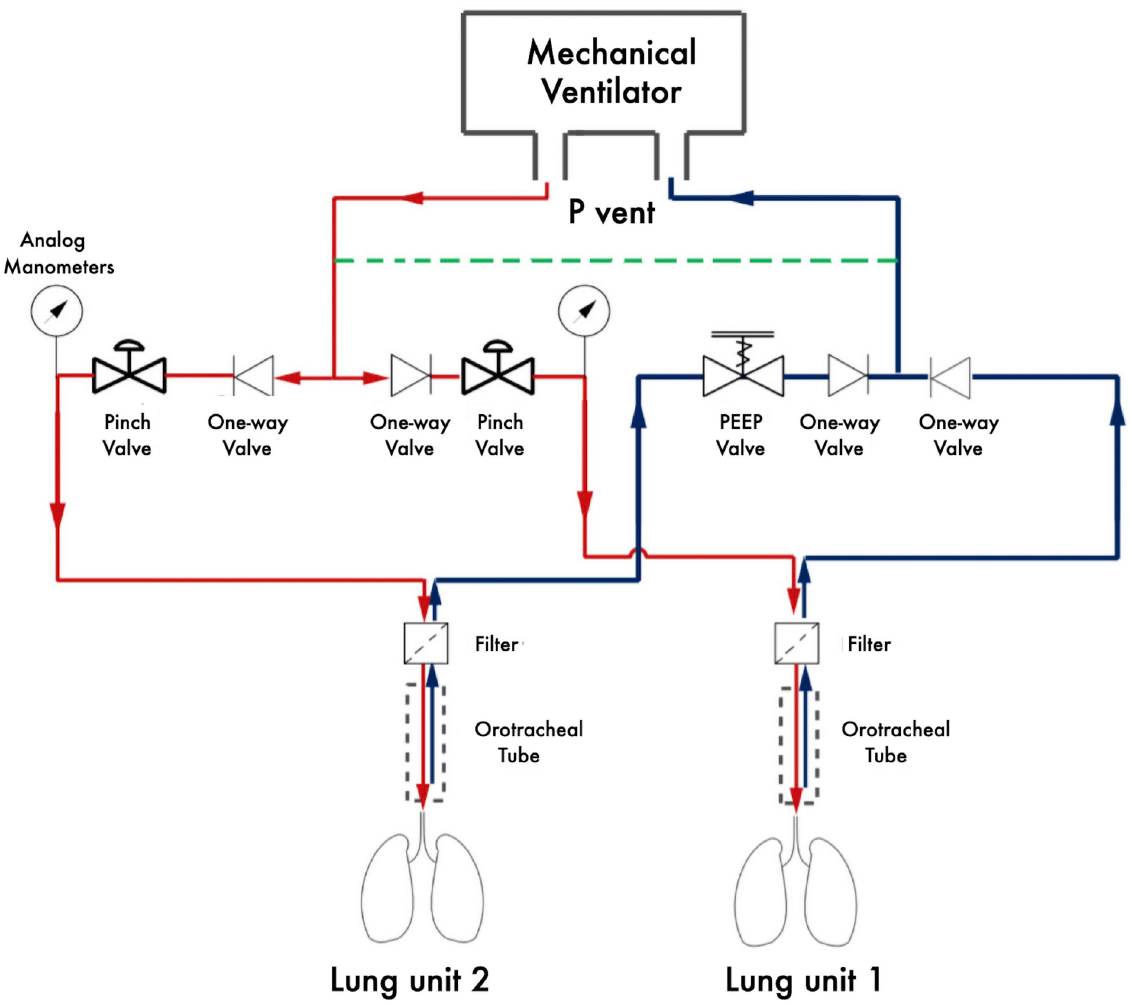
Fig 1. One-line diagram of the ACRA interface. Inspiration and expiration circuits are colored in red and black, respectively. A dashed green line represents a bypass circuit of small